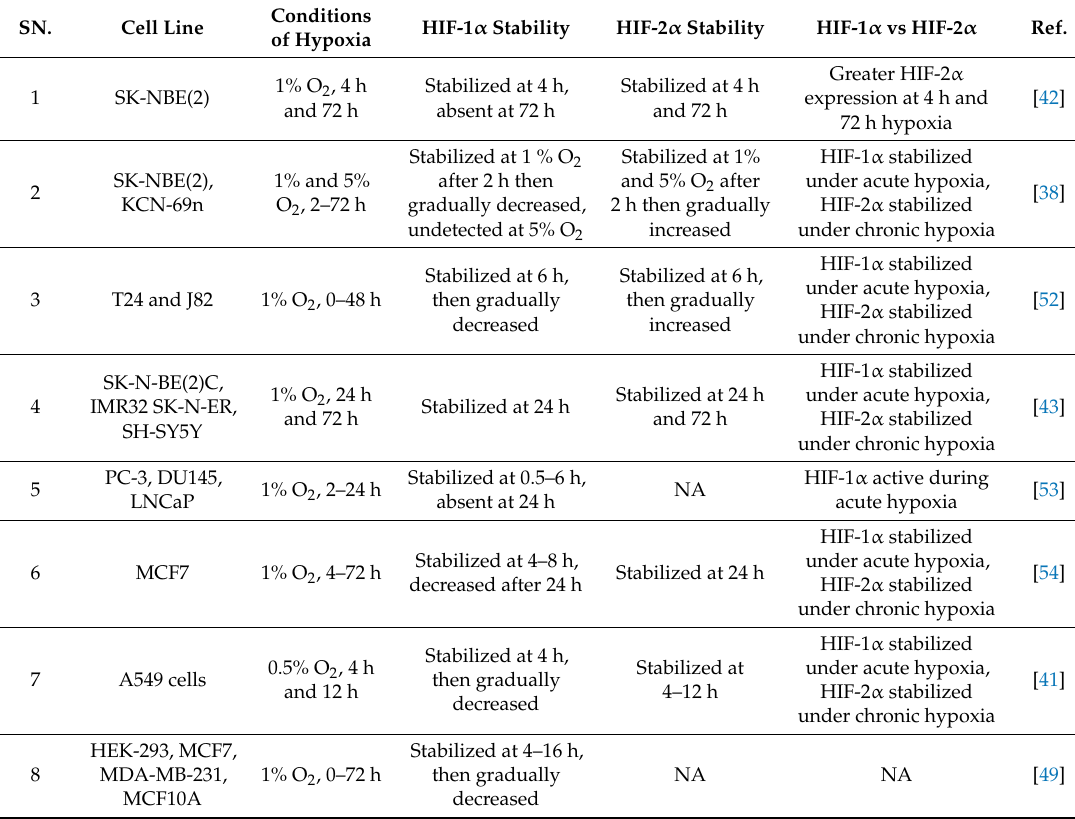
Table 1. HIF-1 α stability and activity under acute and chronic hypoxia in in vitro studies. SN. Cell